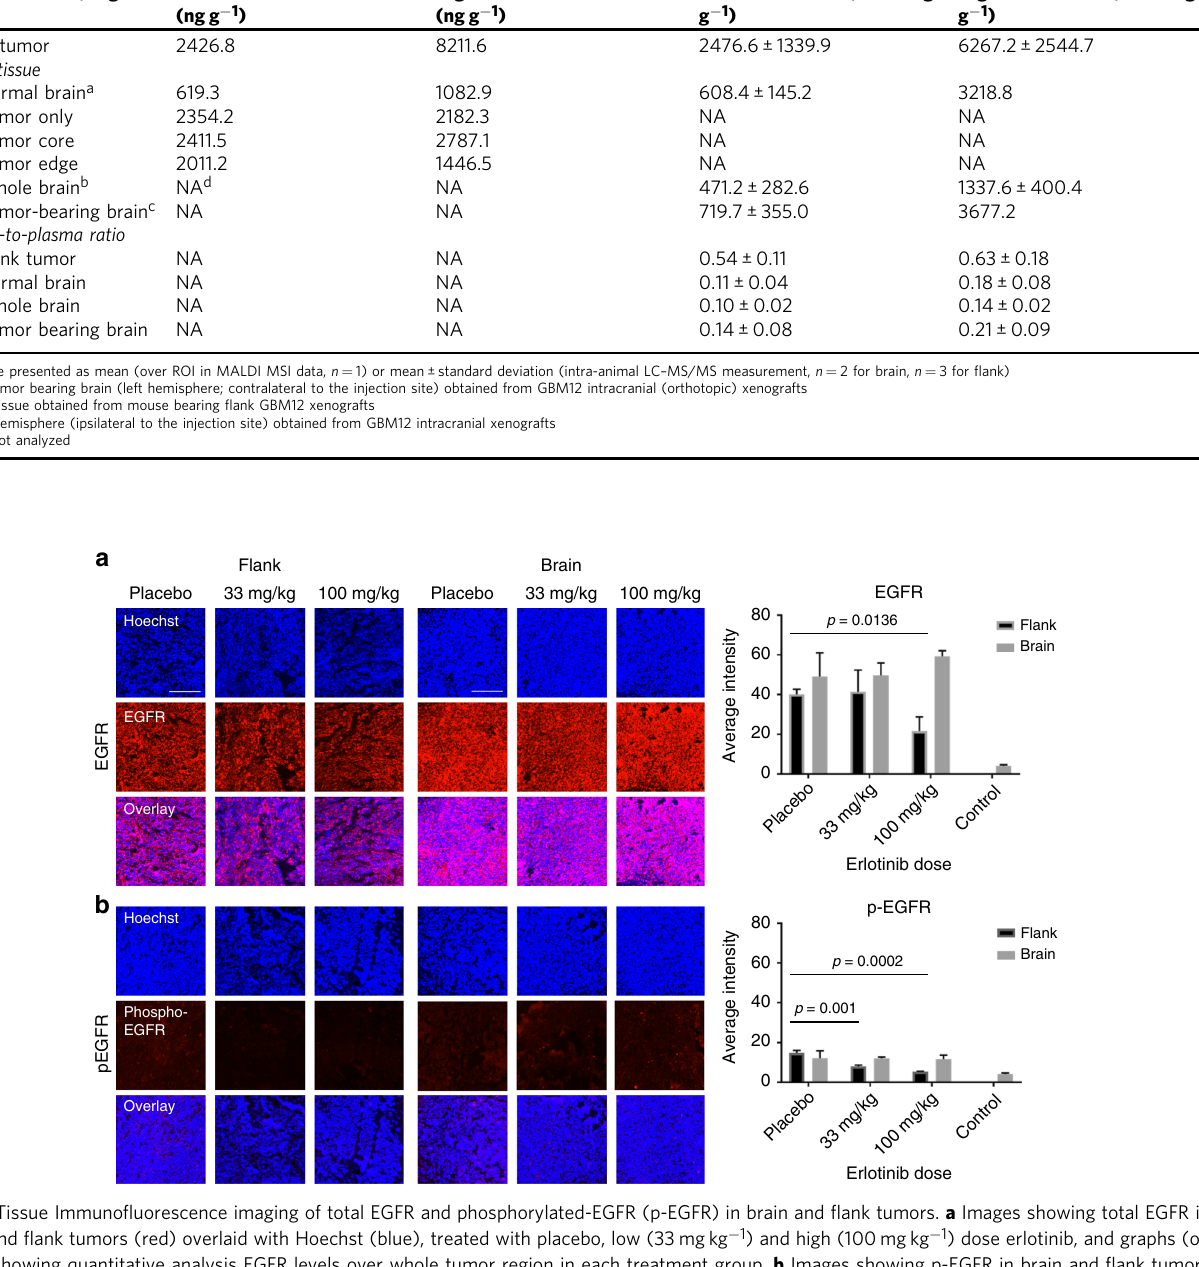
Table 1 Comparison of tissue-to-plasma ratio and concentrations of erlotinib measured by MALDI MSI and LC-MS/MS in IC and fl ank tumors and normal brain, whole brain and tumor bearing brain in animals treated with a low dose of erlotinib (33 mg kg − 1 ) and a high dose (100 mg kg − 1 ) Tumor location/region